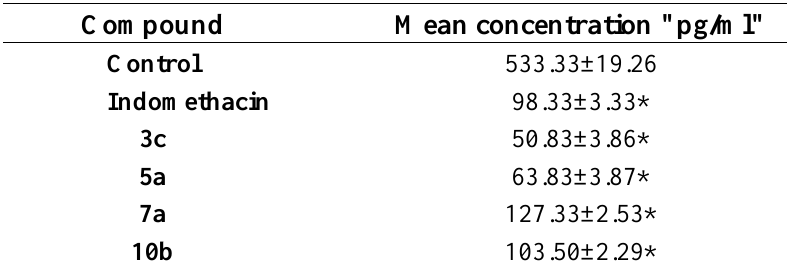
Table 3. PGE Concentration of Selected Compounds. 2